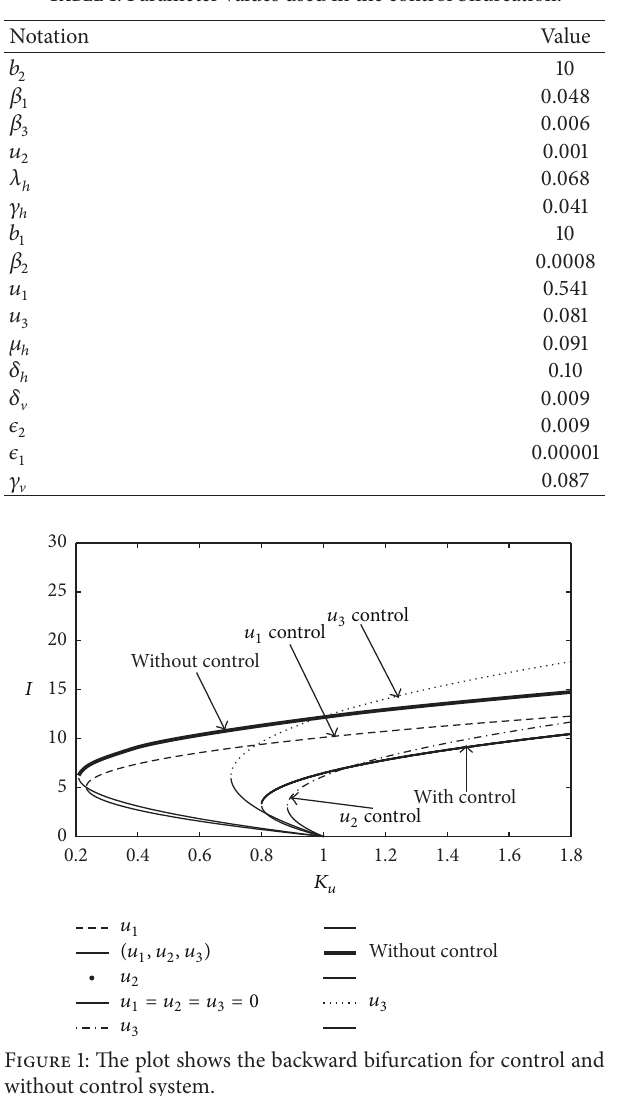
Table 1: Parameter values used in the control bifurcation.